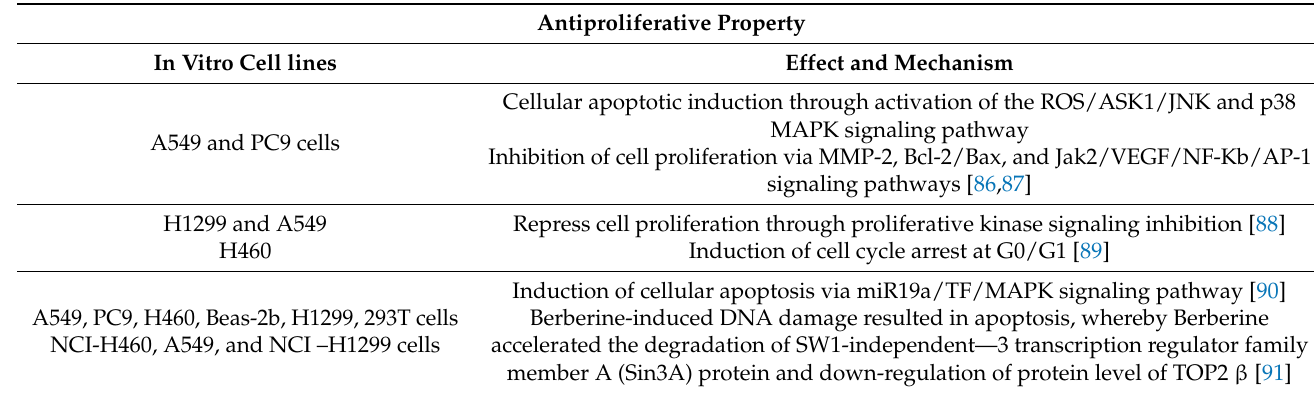
Table 2. Summary of antiproliferative and antimetastatic potential of Berberine on several reported in vitro and in vivo lung cancer